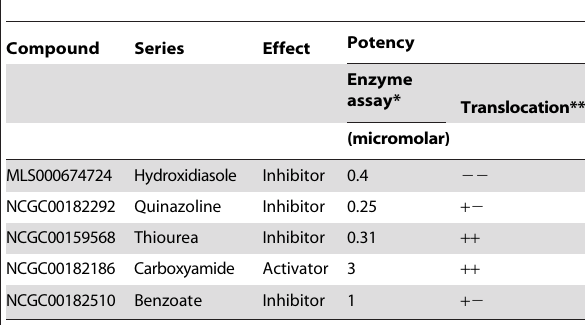
Table 2. Compounds discovered in the spleen qHTS tested for modulation of GCase activity and GCase translocation in cell assays.